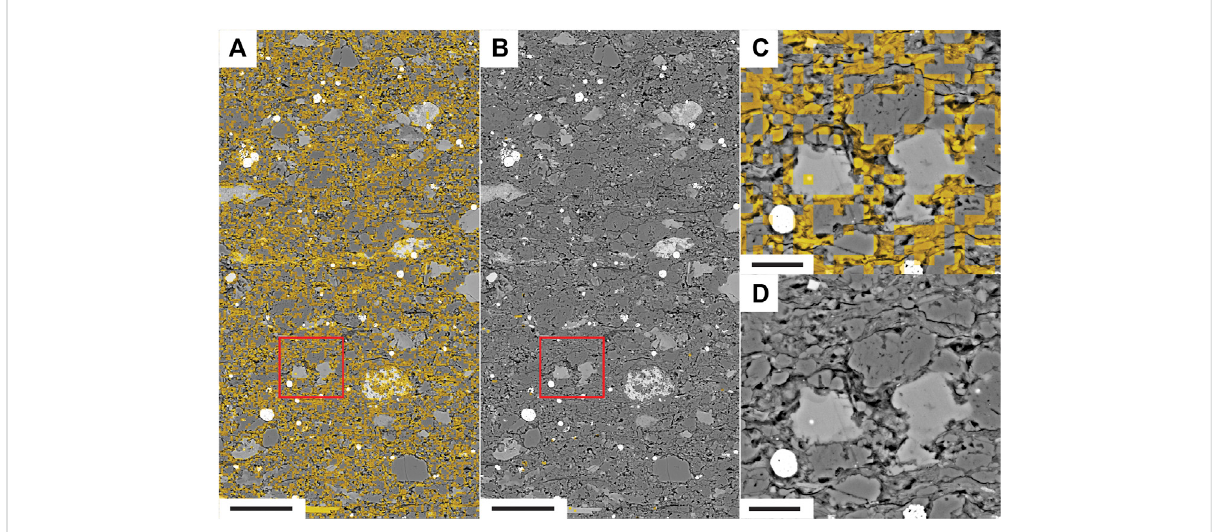
FIGURE 4 Comparison of one mineral per pixel versus three minerals per “ mixel ” modes reveals 27-fold greater proportion of unclassi fi ed pixels in single mineral per pixel mode. Scale bars represent 50 μ m in (A,B) and 10 μ m in (C,D) . Yellow shading indicates unclassi fi ed areas. BSE image of SX22 with mineral map overlay showing unclassi fi ed area for (A) one mineral mode and (B) three minerals mode. (C,D) are zoom in images of red squares in (A,B) respectively. Unclassi fi ed pixels are concentrated in the fi ne-grained matrix and at boundaries of larger